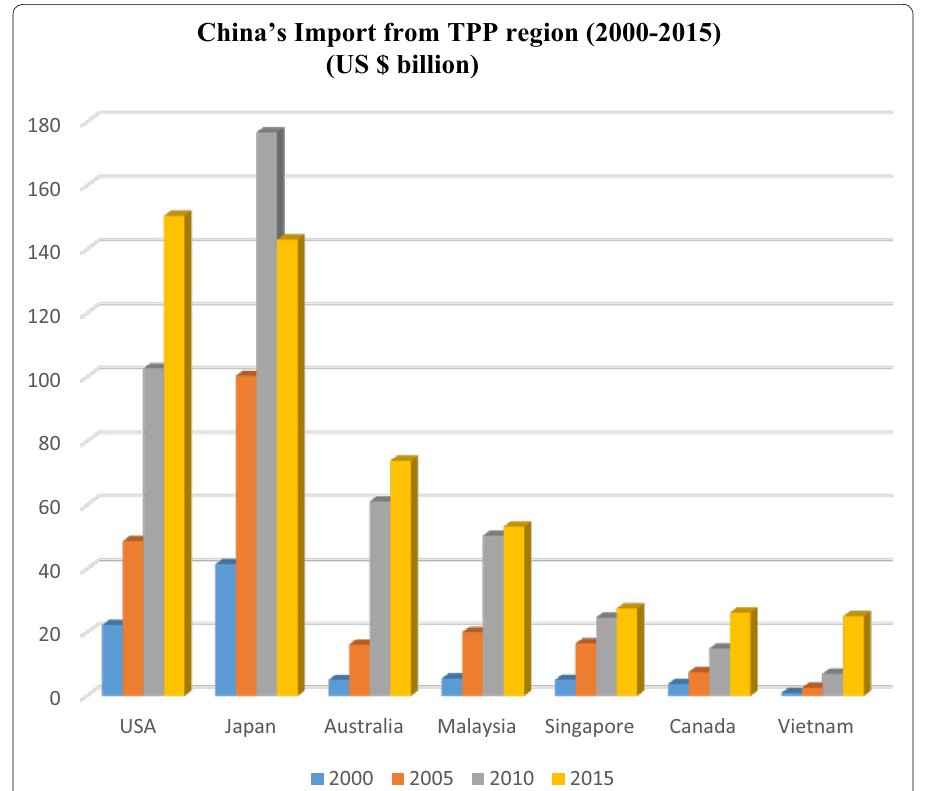
Fig. 4 China’s import from TPP region (2000–2015) (US $ billion). Source : based on data from UN